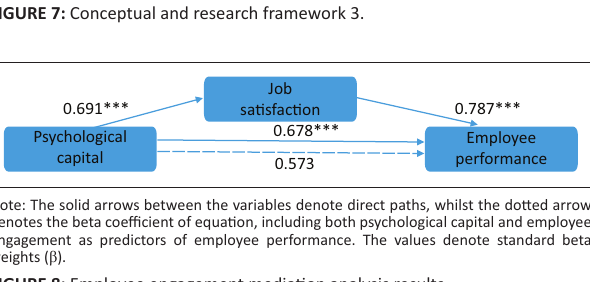
Employee engagement